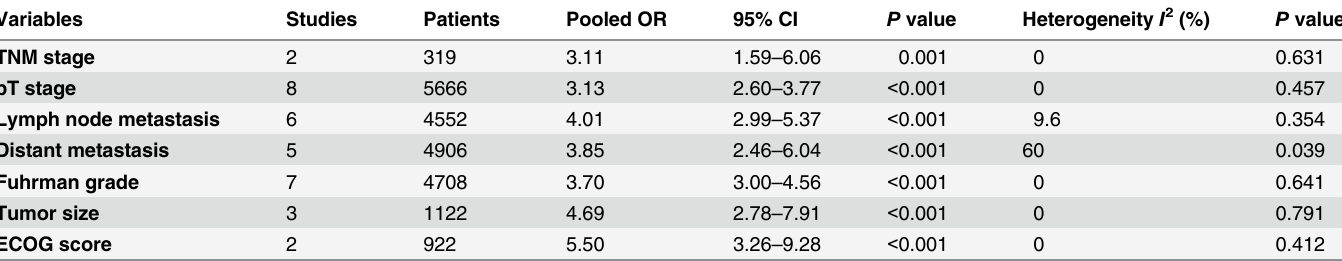
Table 2. Meta-analysis of the association between elevated PC and clinicopathological features of renal cell carcinoma.